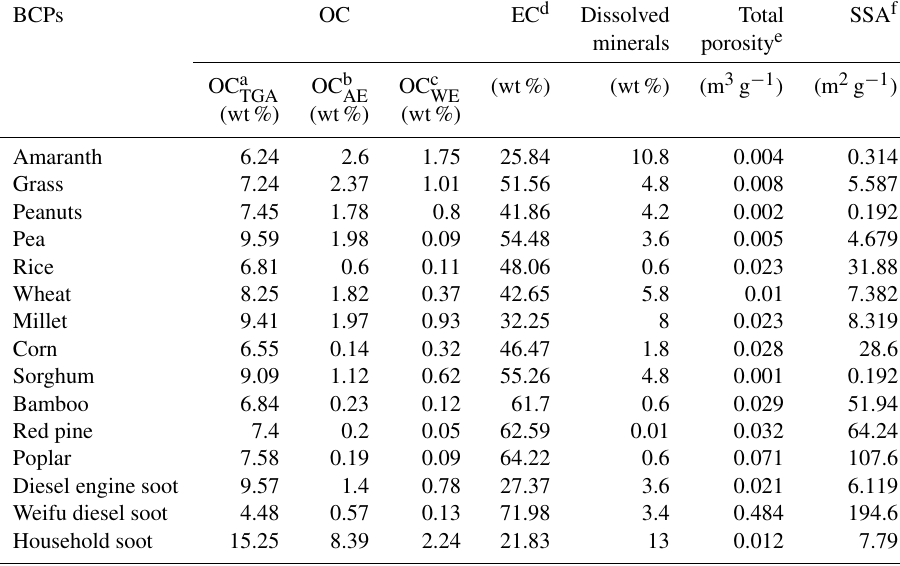
Table 1. Chemical, compositional, and pore properties of different BCPs. BCPs OC EC d Dissolved Total SSA f